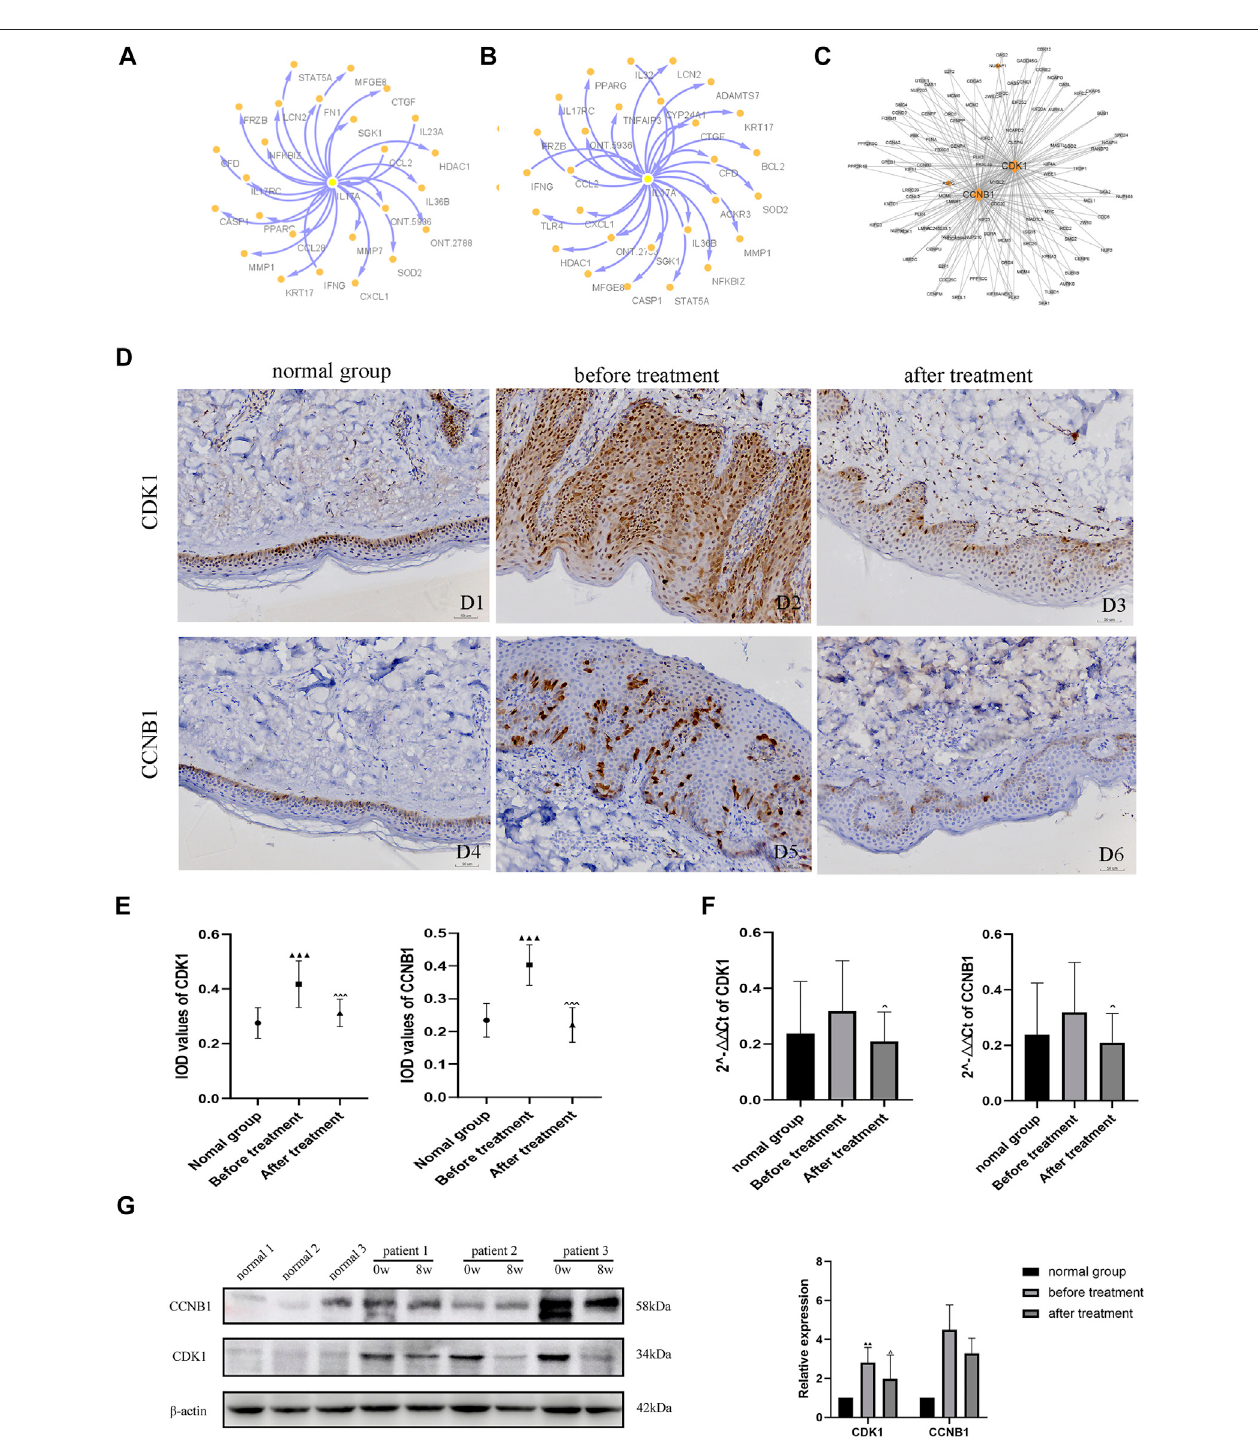
FIGURE5| PPInetworkanalysisandIHC. (A) CoexpressionnetworkofIL-17A(beforevs.afteroxymatrinetreatment). (B) CoexpressionnetworkofIL-17A(before oxymatrine treatment vs. normal control group). (C) PPI network of 205 common DEGs. (D) (D1-D3) IHC staining for CDK1, (D4-D6) IHC staining for CCNB1. D1, D4: normalcontrolgroup;D2,D5:beforeoxymatrinetreatment;D3,D6:afteroxymatrinetreatment. (E) Integratedopticaldensity(IOD)valuesofCDK1andCCNB1. (F) qRT- PCR of CDK1, CCNB1 ( ▲ p < 0.05, ▲▲ p < 0.01, ▲▲▲ p < 0.001 vs. normal control group; ^ p < 0.05, ^^ p < 0.01,^^^ p < 0.001 vs. before oxymatrine treatment). (G) Western blot of CDK1 and CCNB1